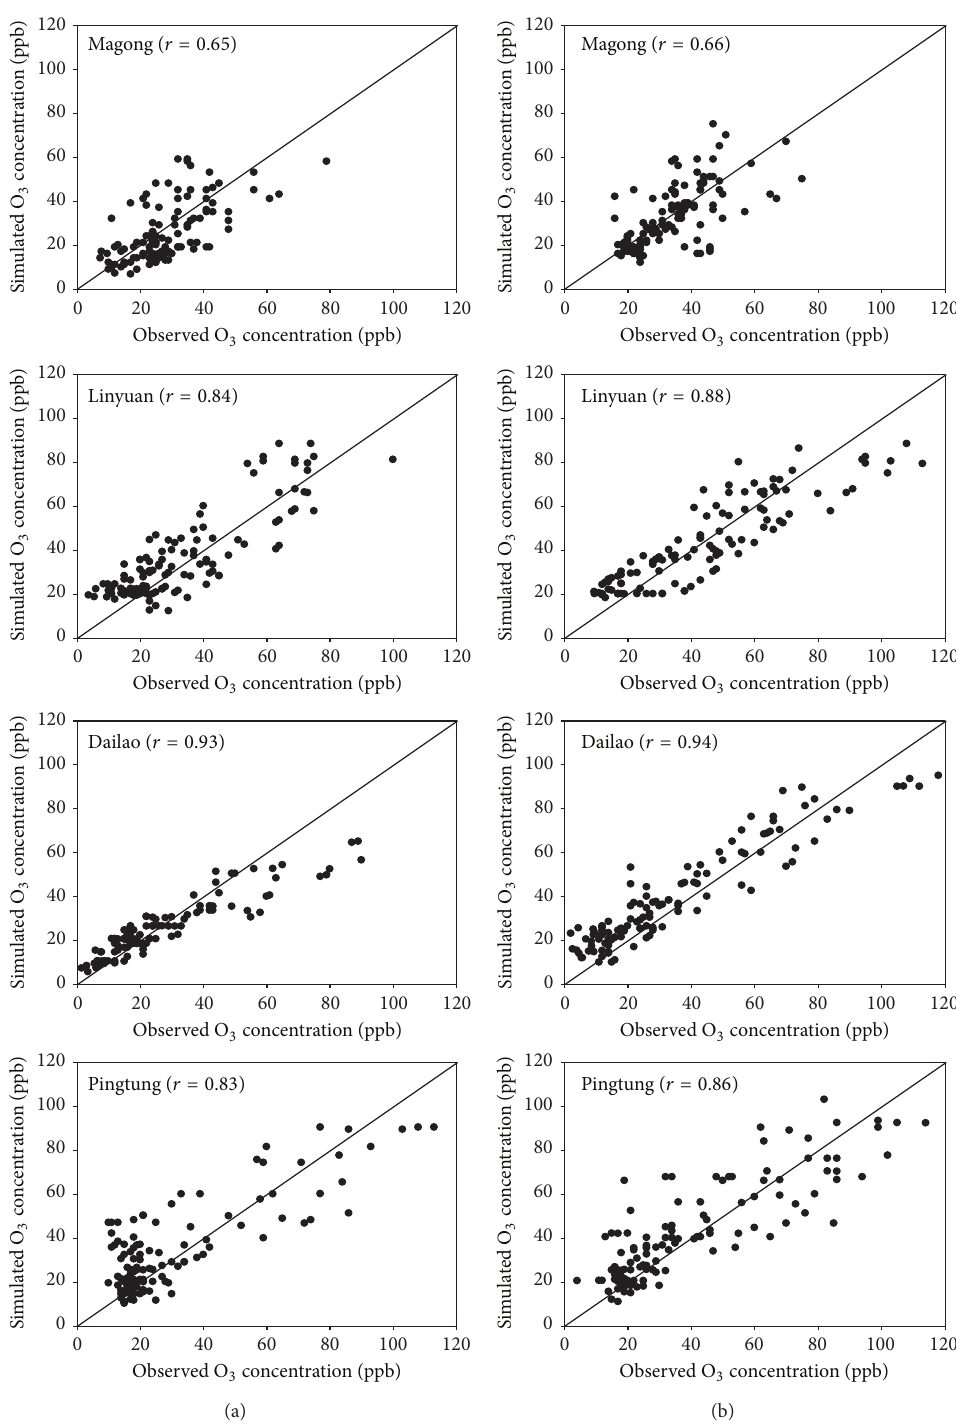
Figure 7: Relationships of simulated and observed O 3 concentration in the ambient air Southern Taiwan ((b) 2013 Usagi; (a) 2011